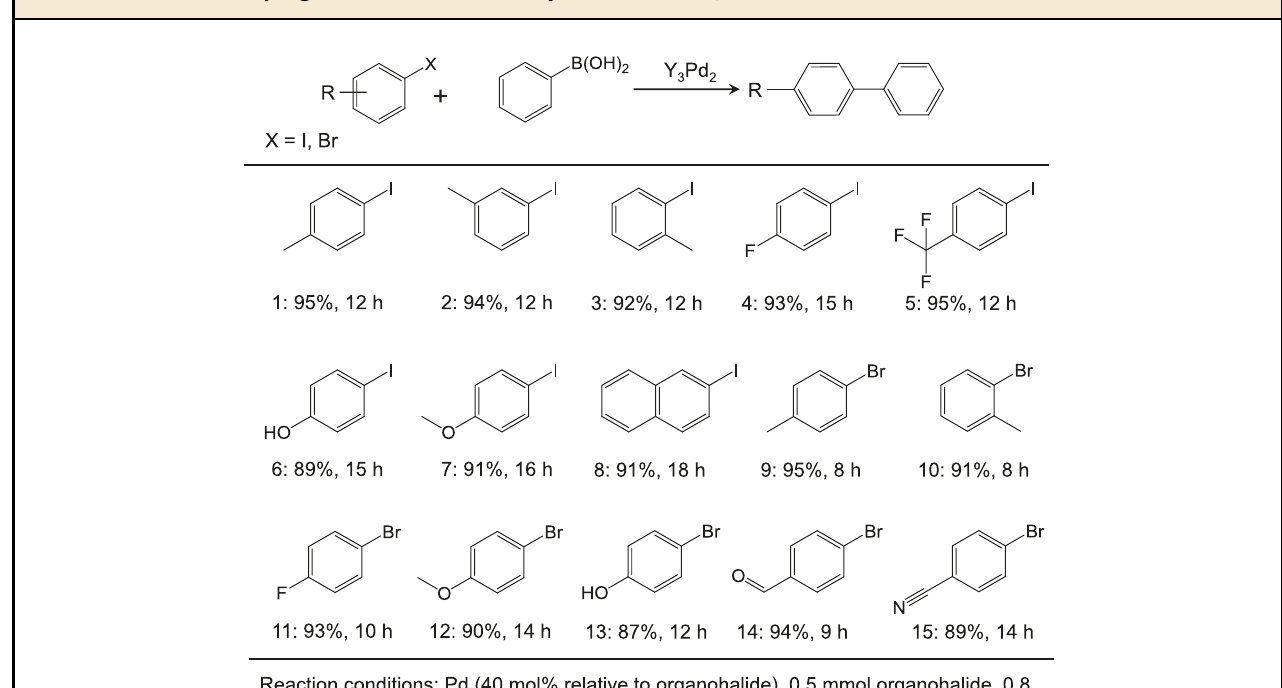
Table 1 Suzuki cross-coupling reactions for various aryl halides over Y 3 Pd 2 .